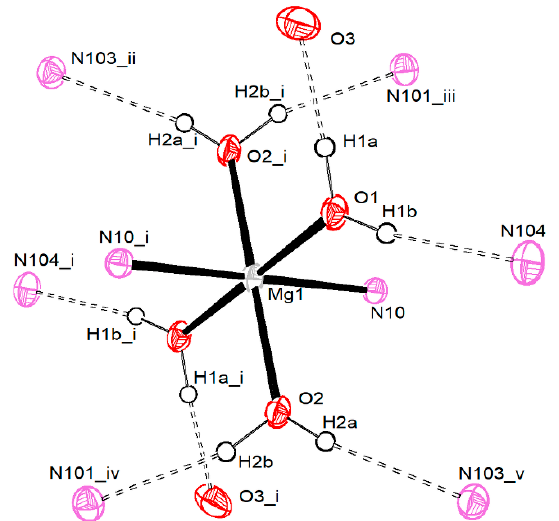
Figure 2. The coordination sphere of Mg 2+ together with the hydrogen bonds involving water mol- ecules.